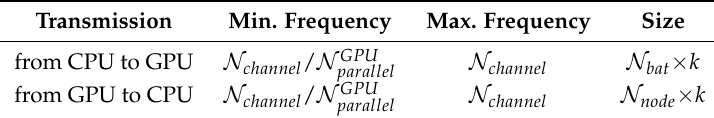
N N × k channel bat parallel N N × channel node parallel